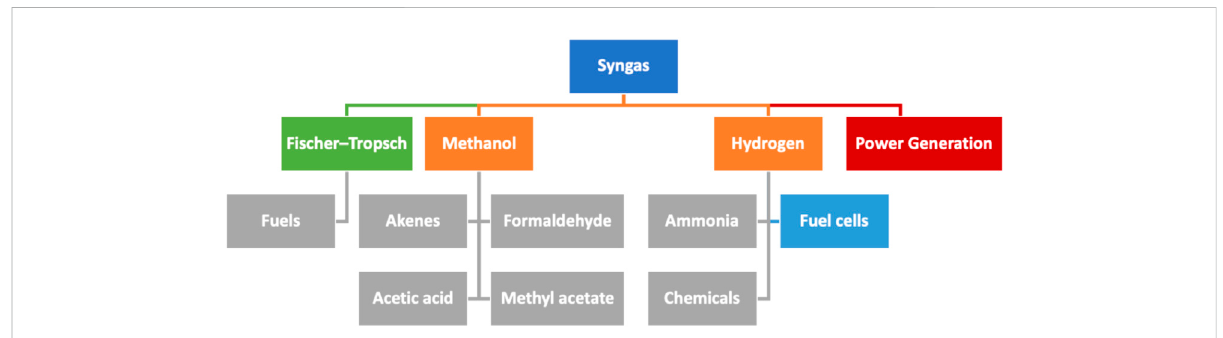
FIGURE 1 Schematic representation of the possible routes for valorizing syngas (in blue). It includes the Fischer – Tropsch process (in green) to produce fuels (in gray), power generation (in red), and the main intermediates (in orange) to produce chemicals (in gray) or being applied in fuel cells (in light